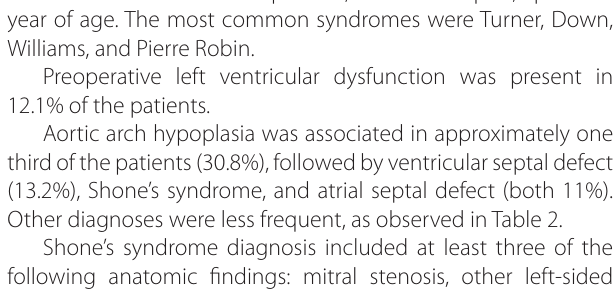
Corrected transposition of the great arteries